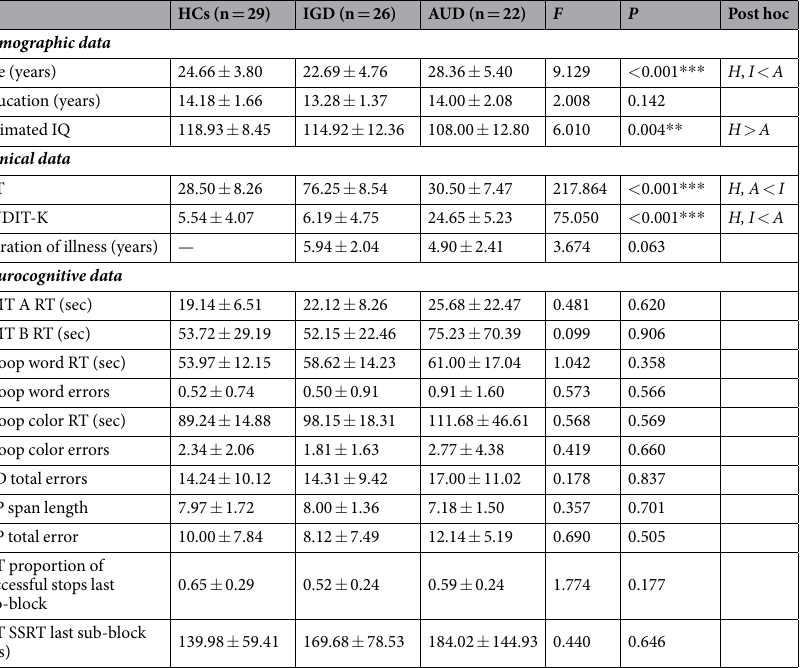
Table 1. Demographic and clinical characteristics of subjects. AUDIT-K = Korean version of the Alcohol Use Disorder Identification Test; IQ = Intelligence quotient; IAT = Young’s Internet Addiction Test; TMT = Trail Making Test; RT = Reaction Time; IED = Intra-Extra Dimensional Set Shift; SSP = Spatial Span Test; SST = Stop Signal Test; SSRT = Stop Signal Reaction Time. Data are mean ± standard deviation. ** P < 0.01; *** P <